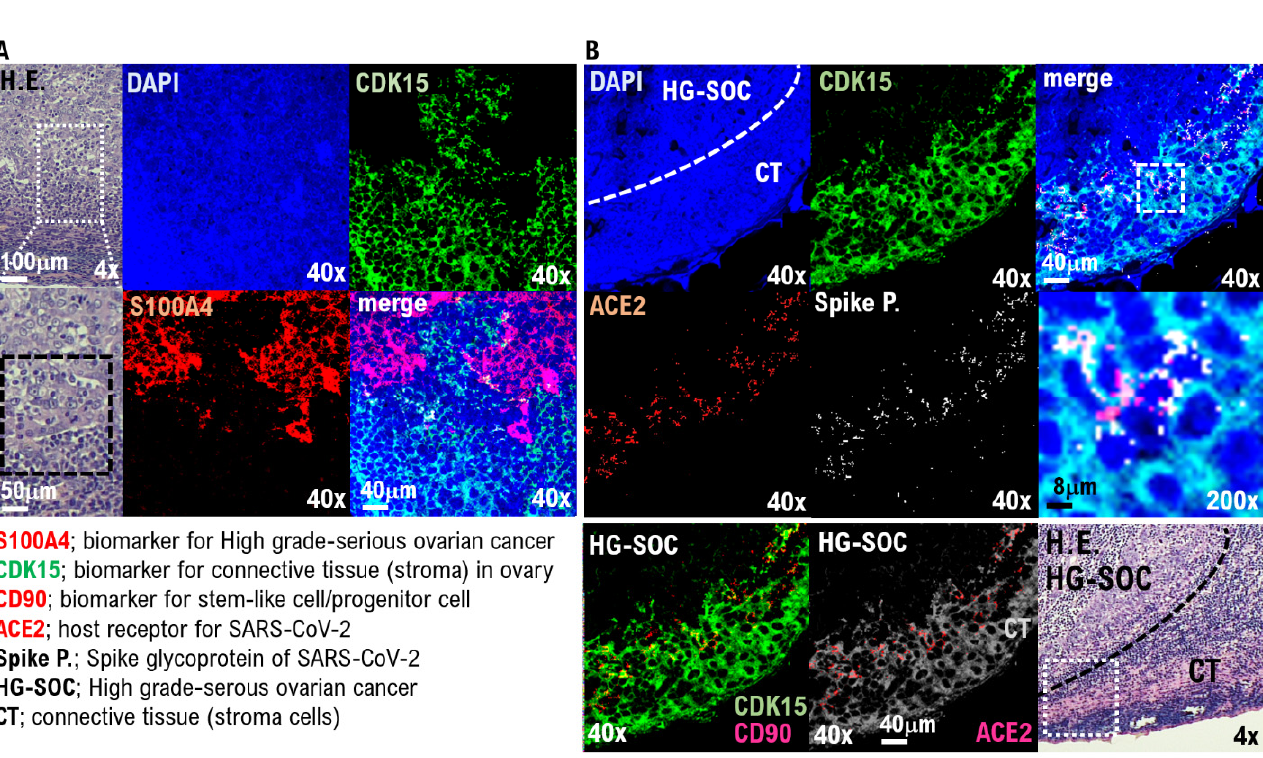
Figure 2. SARS-CoV-2 infection in the connecting tissue in contact with or in the vicinity of HG-SOC micrometastatic niche found in the ovary. SARS-CoV-2 infection in the micrometastatic niche composed of HG-SOC was examined through a molecular pathological method using the left ovarian tumor tissue resected from COVID-19 patients. ( A ) The H.E. image shows growing solid tissue areas and papillary structures. Enlarging the lesion tissue reveals a narrow gap within the solid alveolus (H.E.). From the immunohistochemistry (IHC) staining results using the anti-S100A4 antibody, which is a biomarker of HG-SOC, the cell population with a high degree of cell atypia and nuclear atypia observed in the left ovary was confirmed to be HG-SOC cells. From the IHC staining results using an anticyclin-dependent kinase 15 (CDK15) antibody, which is a connective tissue biomarker (stroma cells), the connective tissue of the ovary was markedly detected. ( B ) The H.E. image shows the boundary between the HG-SOC tissue and the connecting tissue (CT) of the ovary. A strong expression of ACE2 and CD90, which are biomarkers for stem-like cells/progenitor cells, was observed in some cells of the connecting tissue in contact with or in the vicinity of the micrometastatic niche of HG-SOC found in the left ovarian tissue. Immunohistochemistry staining was performed using a monoclonal antibody against SARS-CoV-2 spike glycoprotein. The spike glycoprotein was clearly detected, suggesting that the SARS-CoV-2 virus may be present in the HG-SOC tissue. From the IHC staining results using the antispike glycoprotein of SARS-CoV-2 monoclonal antibody, spike protein (Spike P.) was observed in and around the cells of the connecting tissue positive for ACE2